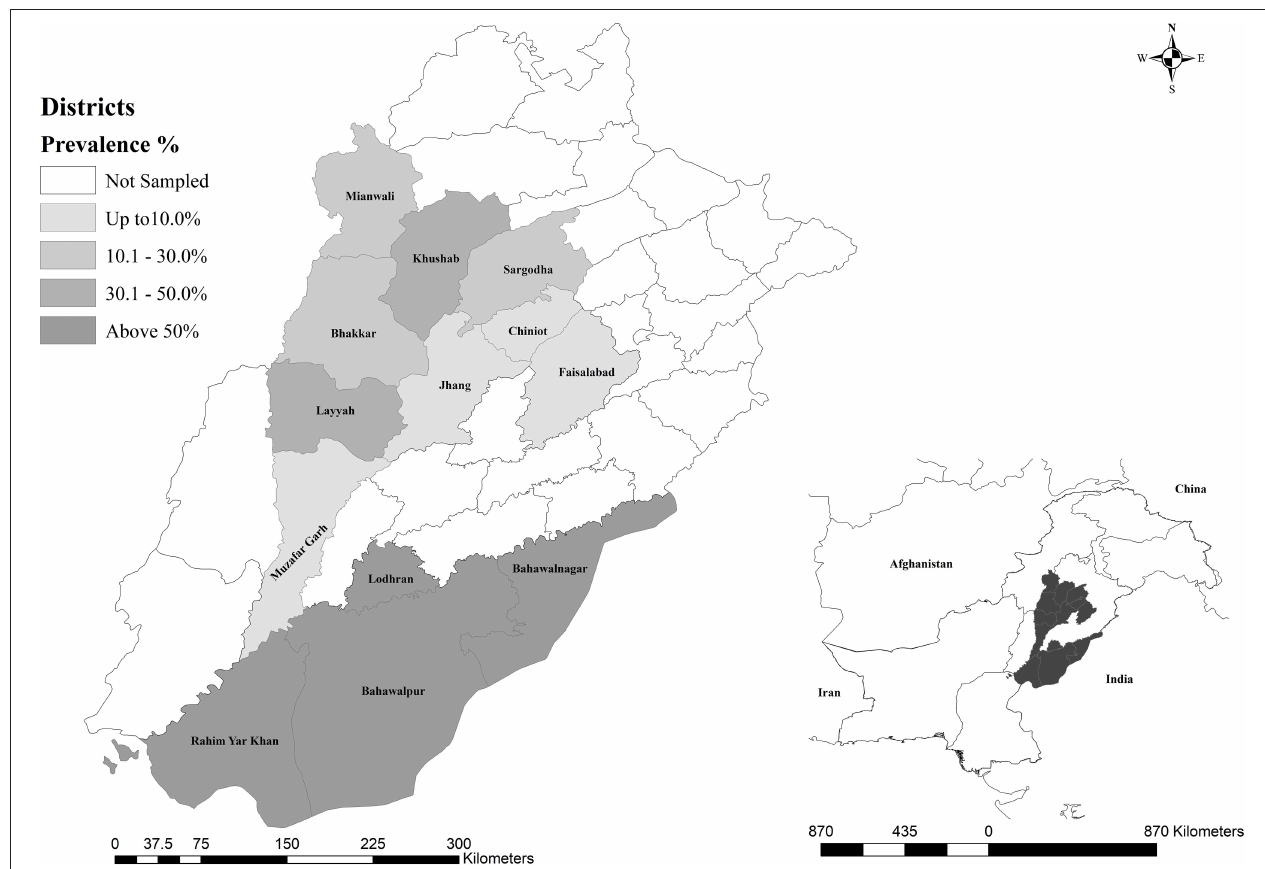
FIGURE 1 | Geographical representation of dromedarian coxiellosis in sampled districts of Punjab,